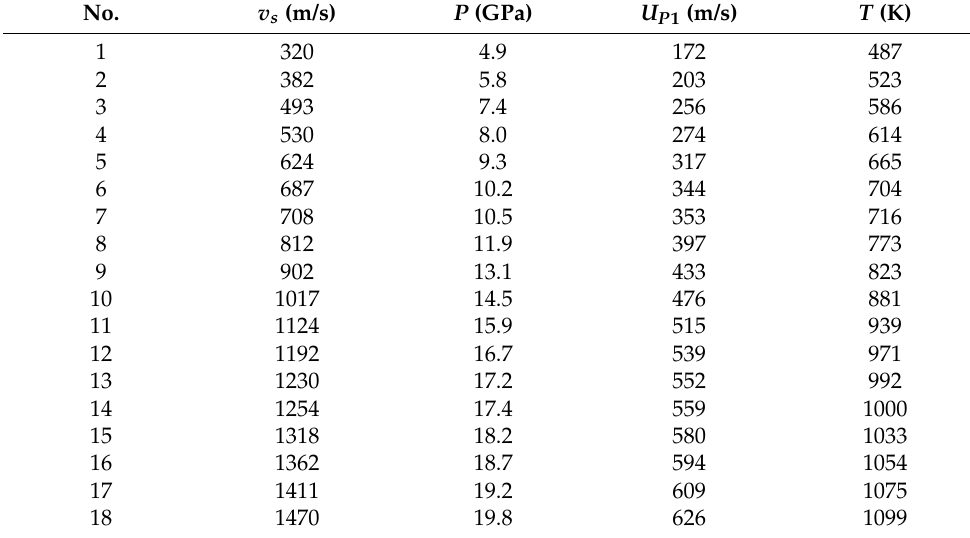
Table 4. The relevant reaction parameters during the fragment impact